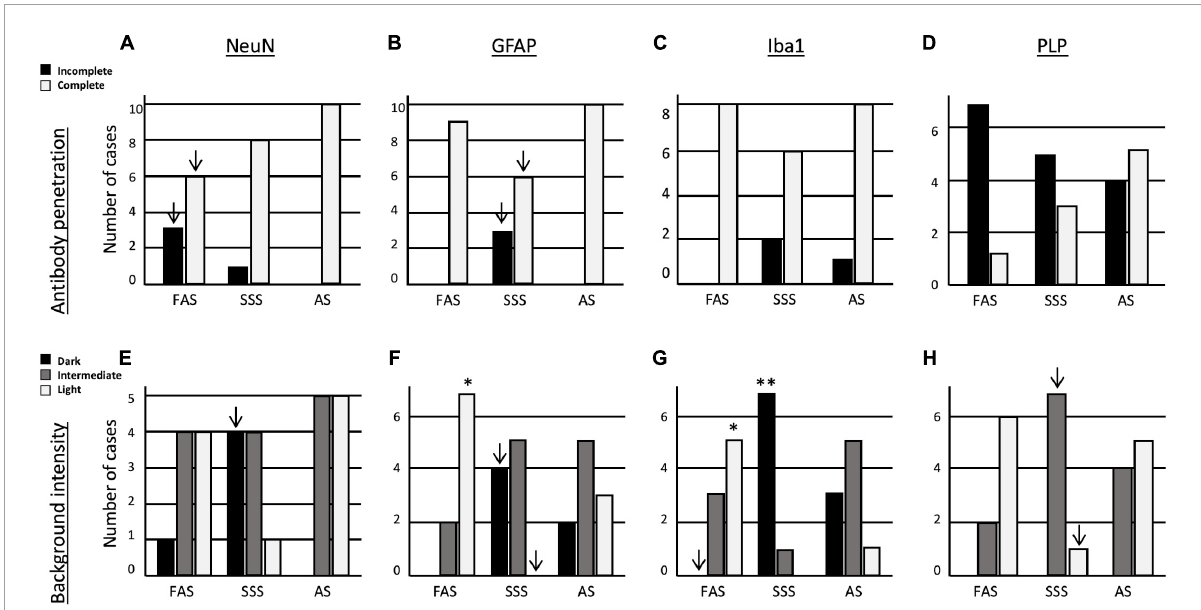
FIGURE6 Bar charts of the immunolabeling quality. Antibody penetration of (A) NeuN, (B) GFAP, (C) Iba1, and (D) PLP. Tissue background of (E) NeuN, (F) GFAP, (G) Iba1, and (H) PLP. Significance after Bonferroni correction: ∗ p < 0.05, ∗∗ p < 0.001; ↓ = significant before Bonferroni correction; FAS, formaldehyde solution; SSS, salt-saturated solution; AS, alcohol